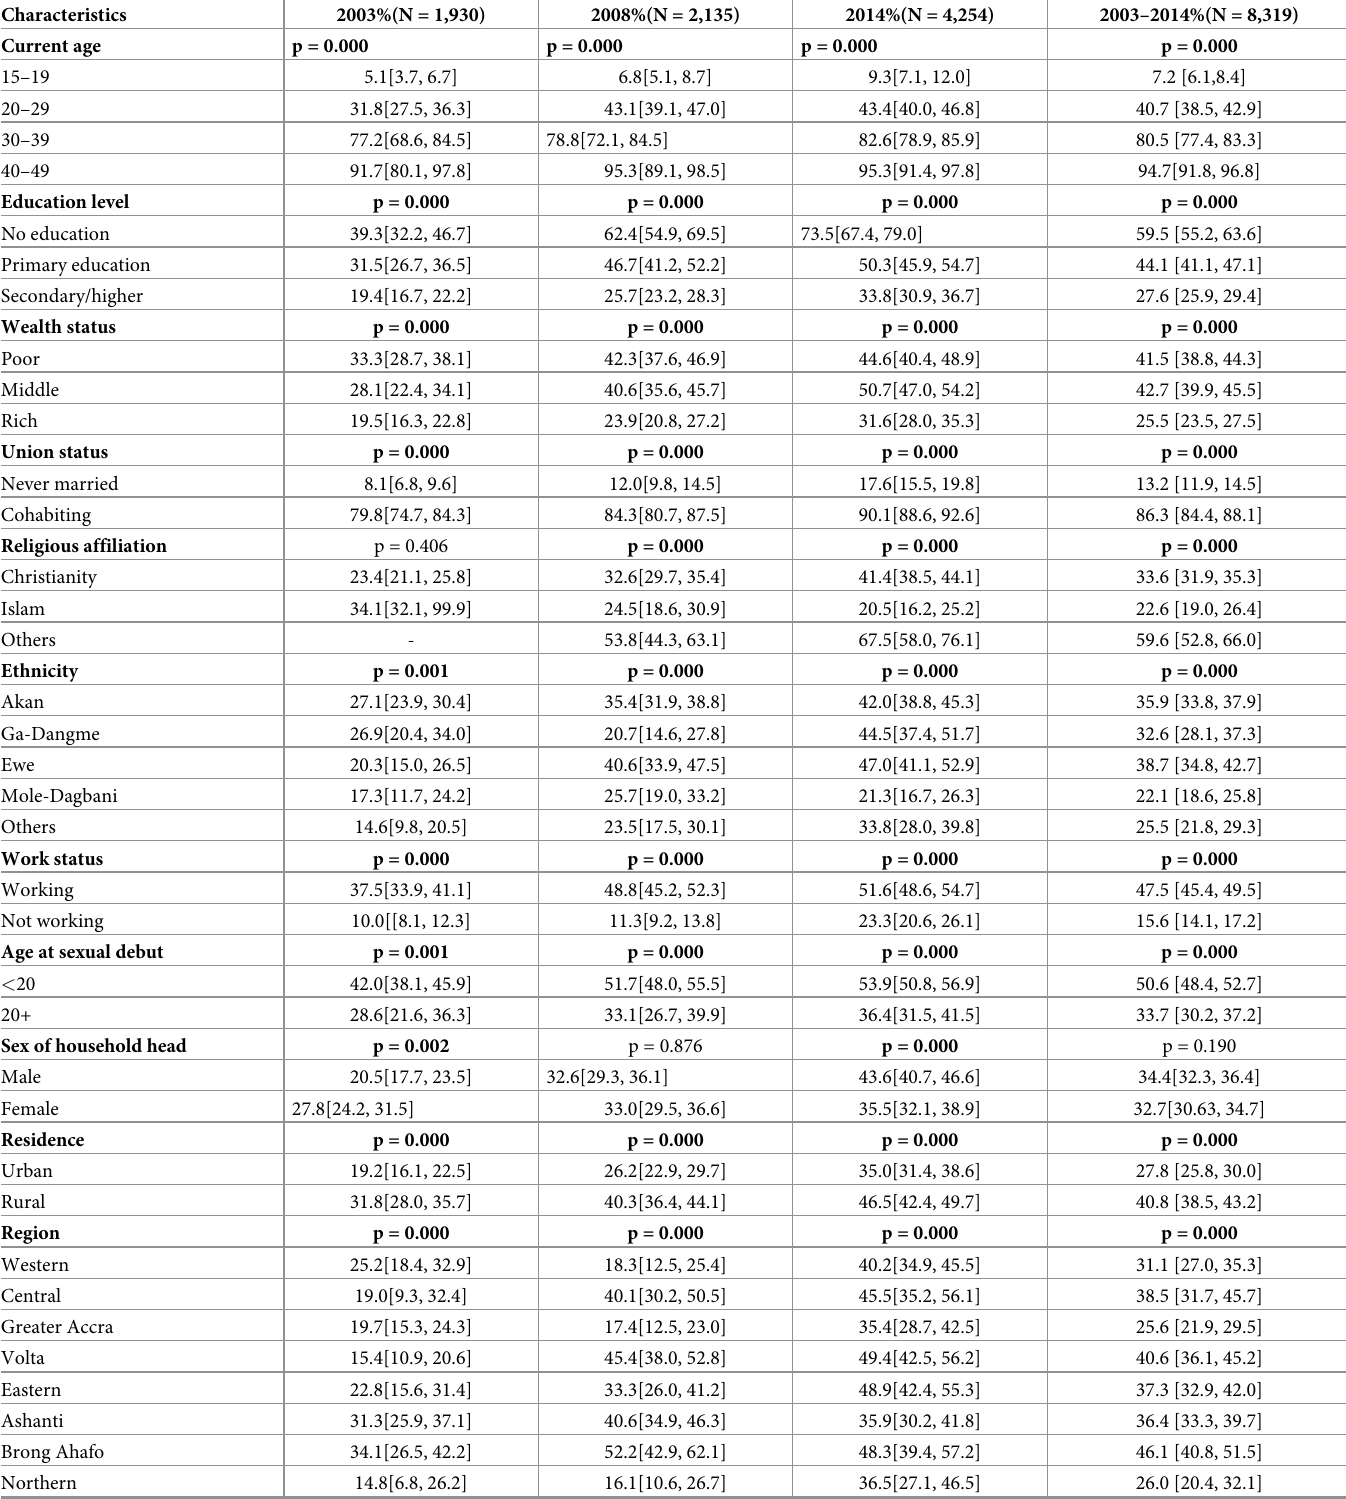
Table 2. Nonmarital fertility levels by background characteristics.